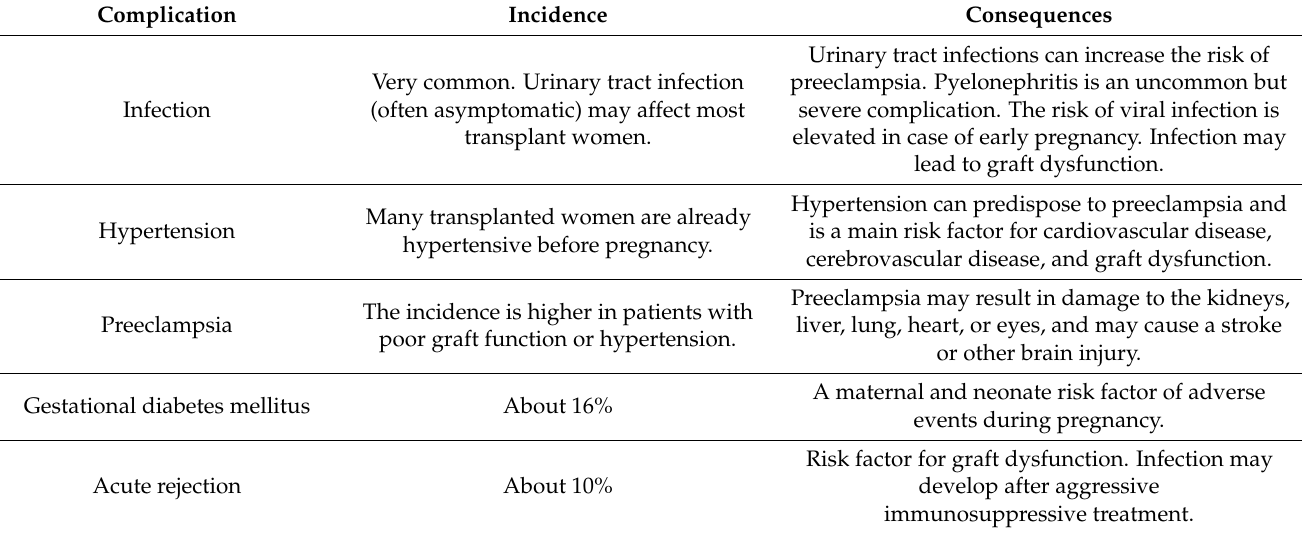
Table 1. Main maternal adverse events during pregnancy after kidney